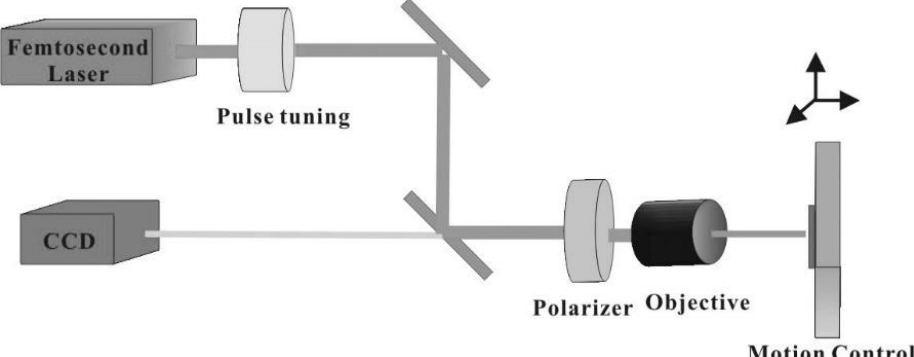
Figure 14. Experiment setup for laser machining .